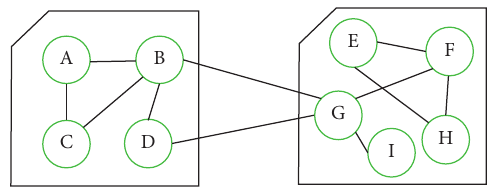
Figure 2: Some maintenance actions on Figure 1.